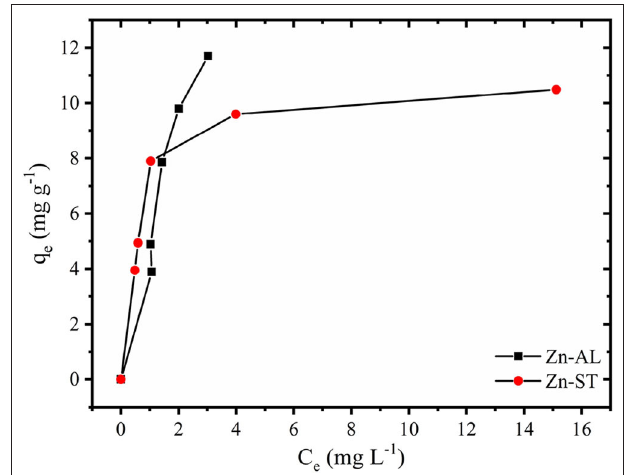
FIGURE 8 | Adsorption of Cu (II) ions into ZnO samples at 25 ◦ C.